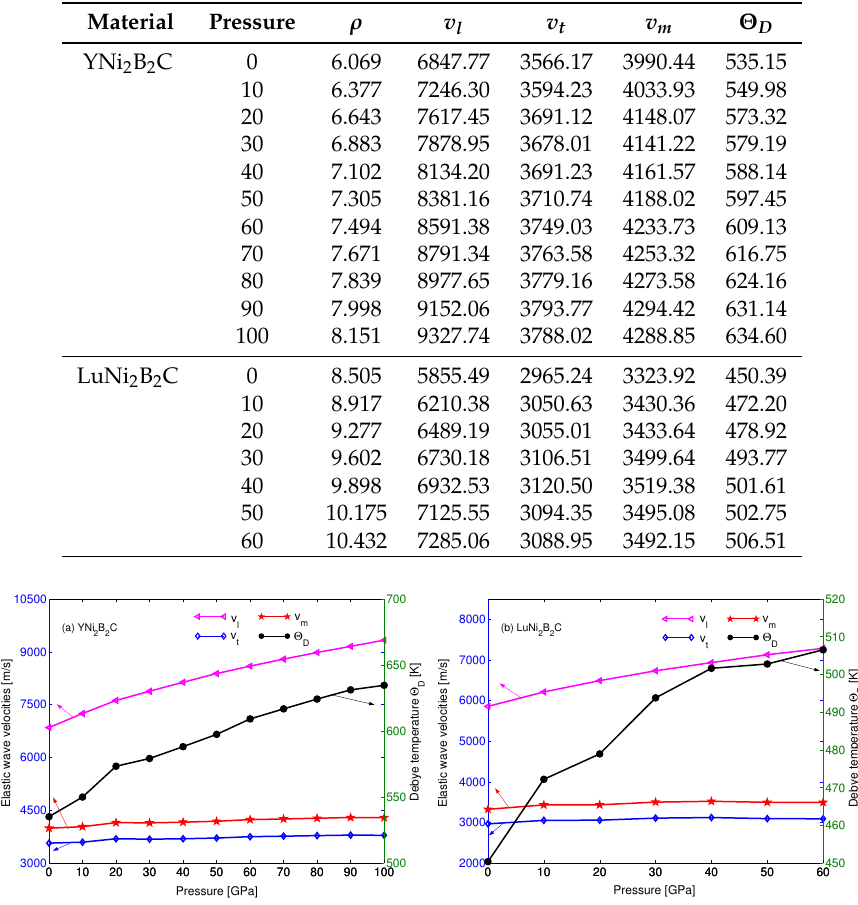
Table 3. The density ( ρ in g/cm 3 ), longitudinal ( v l ), shear ( v t ) and average ( v m ) elastic wave velocities (in m/s) and Debye temperature ( Θ D in K) of RNi 2 B 2 C (R=Y, Lu) under different pressures.